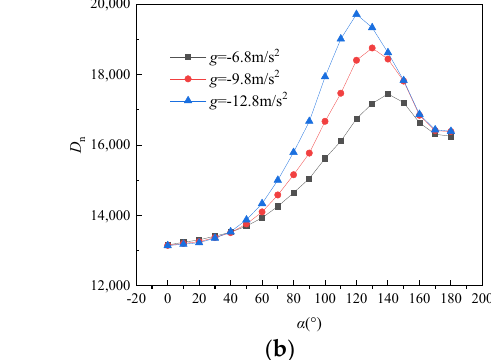
Figure 11. The changes in h with L / D and in Dn with α under different pressure conditions: ( a ) L/D , ( b ) α (°).